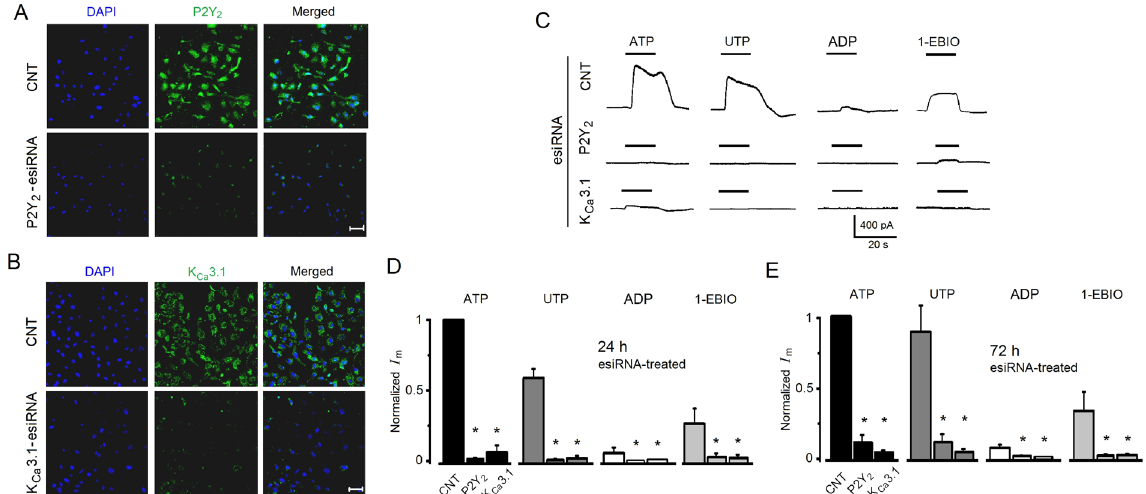
Figure 5. P2Y 2 and K Ca 3.1 protein expression and electric response to agonists in esiRNA transfected SKOV-3 cells. ( A ) Analysis by immunocytochemistry after 48 h of esiRNA treatment in control (CNT) and P2Y 2 - esiRNA-treated groups. Panels show the fluorescence signal for DAPI (blue) in the first column, the signal obtained with a specific antibody against P2Y 2 receptor protein (in green) in the second column, and the corresponding merged image. ( B ) Similar analysis was made in K Ca 3.1-esiRNA-treated cells using an antibody against K Ca 3.1 channel protein (in A and B bar = 50 µ m). ( C ) Traces illustrate current response elicited by agonists (all 3 µ M) or 1-EBIO (300 µ M) in SKOV-3 cells 24 h after esiRNA transfection. In ( D and E ) traces illustrate current responses in SKOV-3 cells 24 h and 72 h after esiRNA transfection, respectively. Currents were normalized against the ATP-elicited response in the CNT group (18–19 cells in each condition). Every set of bars corresponds to either CNT, P2Y 2 -esiRNA, or K Ca 3.1-esiRNA as indicated in the group for ATP application ( * p < 0.05, experimental condition vs. respective